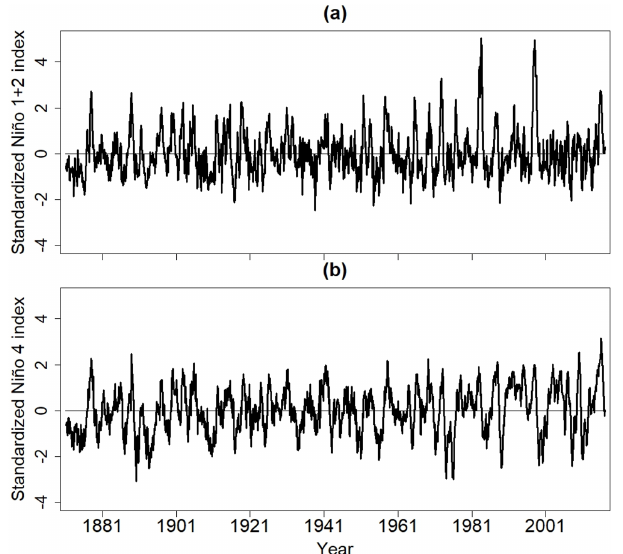
Figure 4. The 20-year sliding skewness of (a) June–September and (b) August–September all-India rainfall (AIR) and full time series for the Niño 1 + 2 and Niño 4